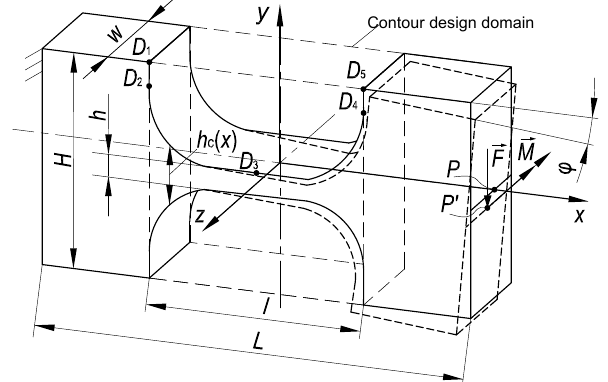
Figure 1. Notch flexure hinge with a variable hinge height within the contour design domain, the geometric parameters and the de- flected state as a result of a moment and/or a transverse force load.